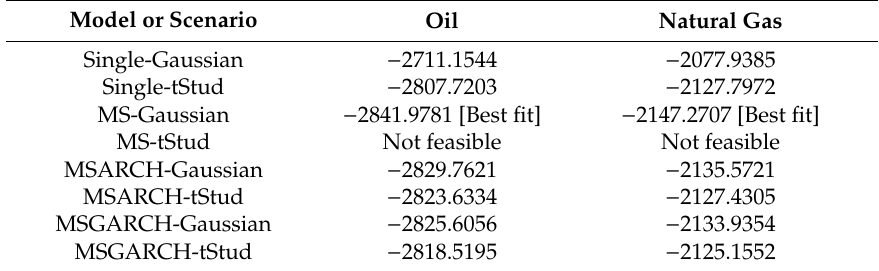
Table 3. Single and multiple regime recursive AIC fitting test for the three commodities’ time series of